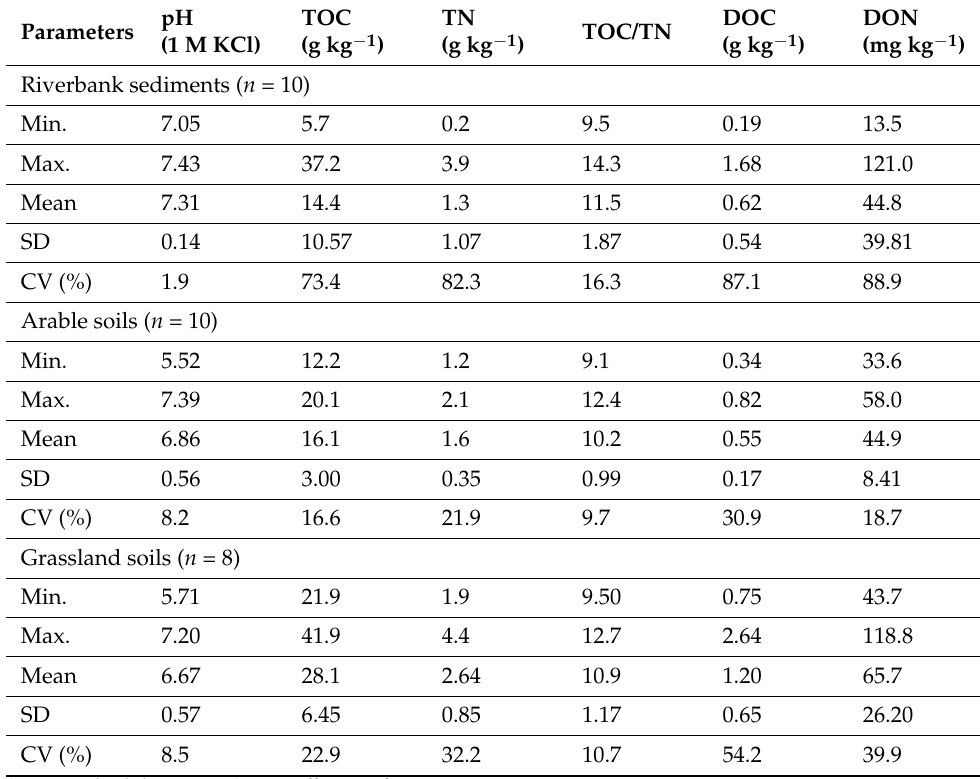
SD—standard deviation; CV—coefficient of